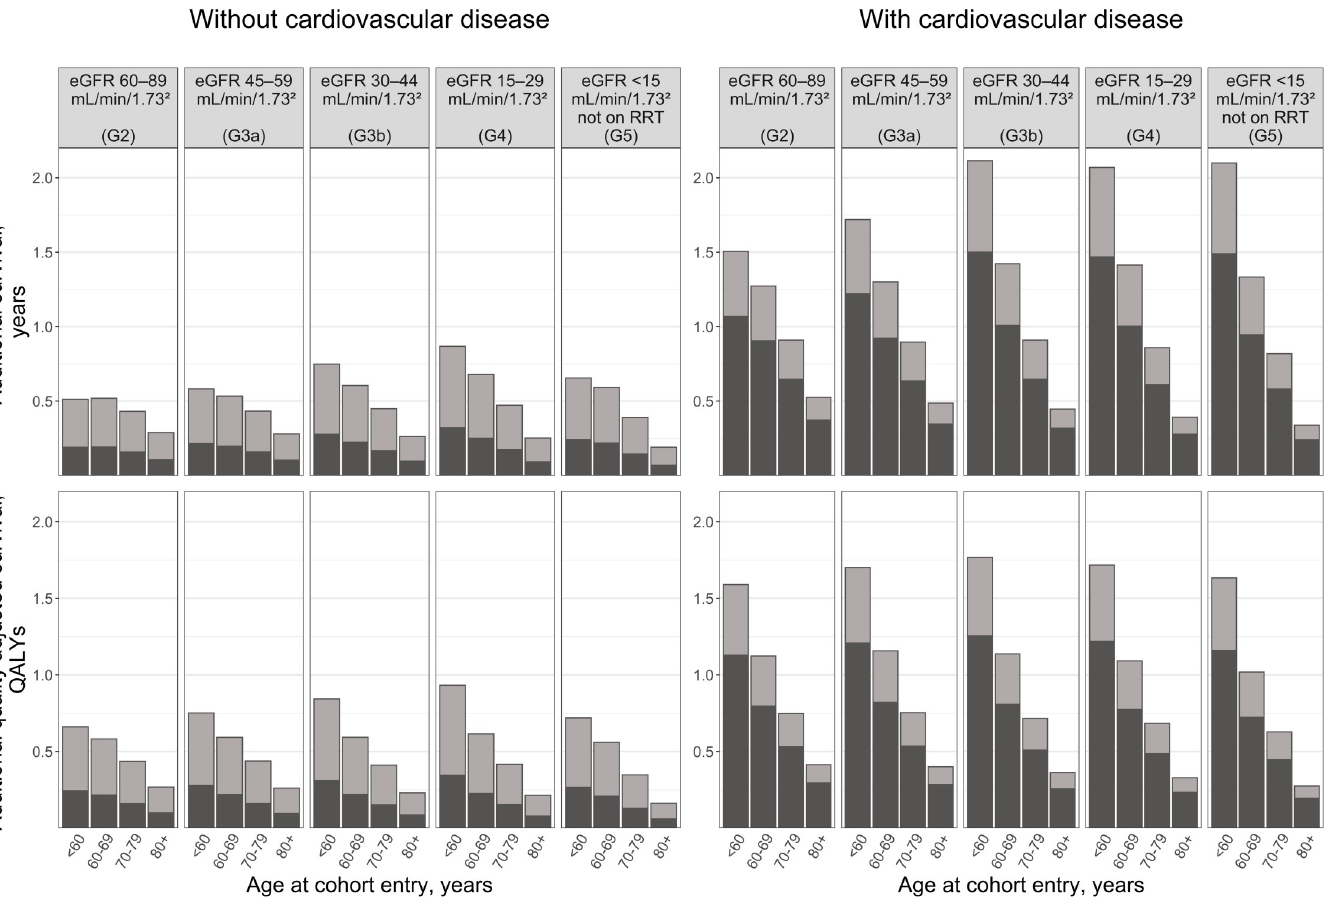
Fig 4. Predicted life years and QALYs gained with cardiovascular prevention medications as per (a) use in 2013 compared to no use (black bars) and additional gains with (b) optimal guideline-indicated use in 2019 (grey bars) by CVD history, age, and eGFR category at cohort entry. CVD, cardiovascular disease; eGFR, estimated glomerular filtration rate; NICE, National Institute for Health and Care Excellence; QALY, quality-adjusted life year; RRT, renal replacement therapy. The predictions are based on a random sample of 64,000 patients from the whole cohort. Of the patients indicated for particular cardiovascular prevention treatment in 2019, 37% of those without CVD and 71% of those with CVD were projected to have been treated in 2013. These proportions were calculated using data on patients that were in the study cohort in 2013 and the 2019 UK NICE guidelines. See Methods and S1 Methods in S1 Text for more information.